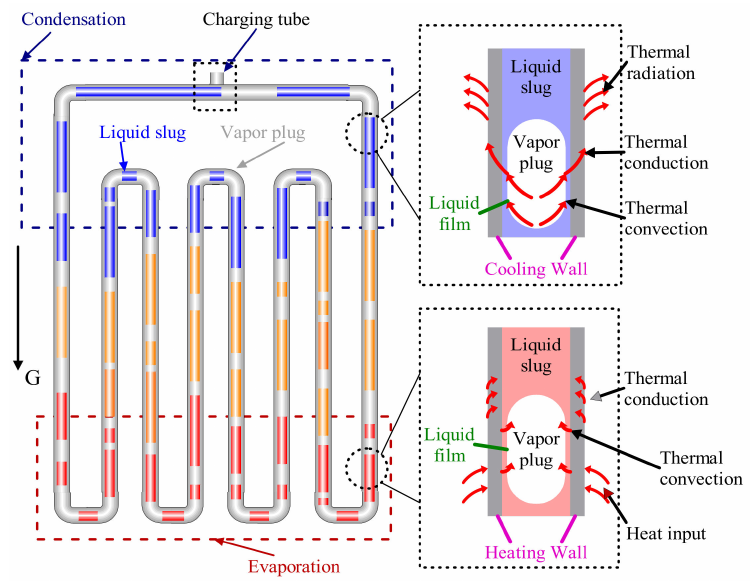
Figure 1. Working process of